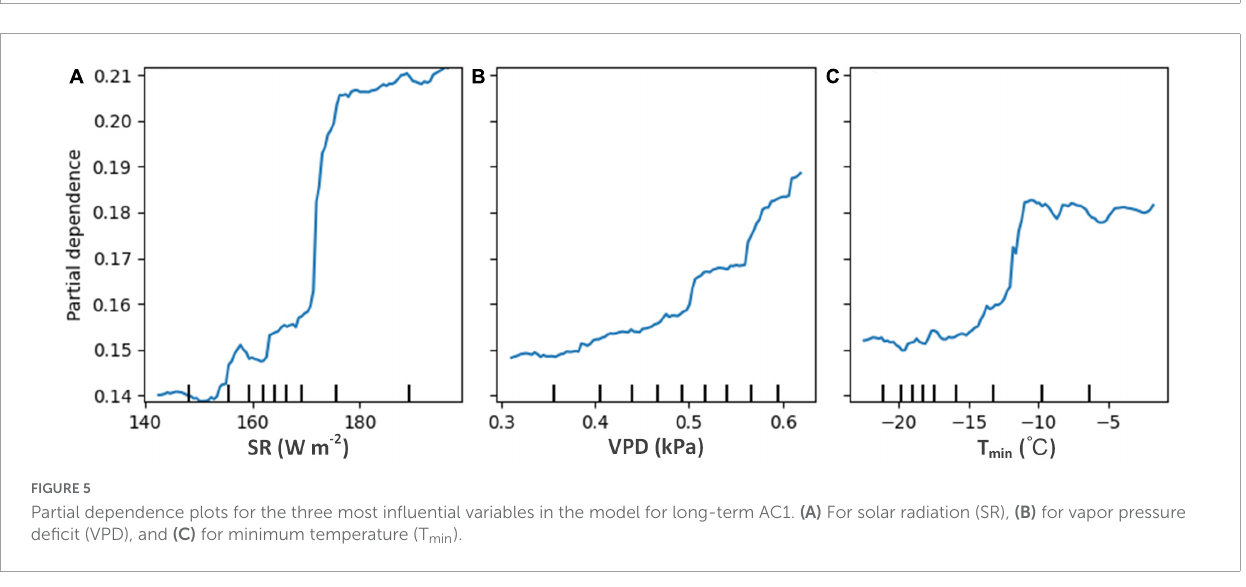
TABLE 2 Temporal trends of forest resilience for different time periods and plant functional